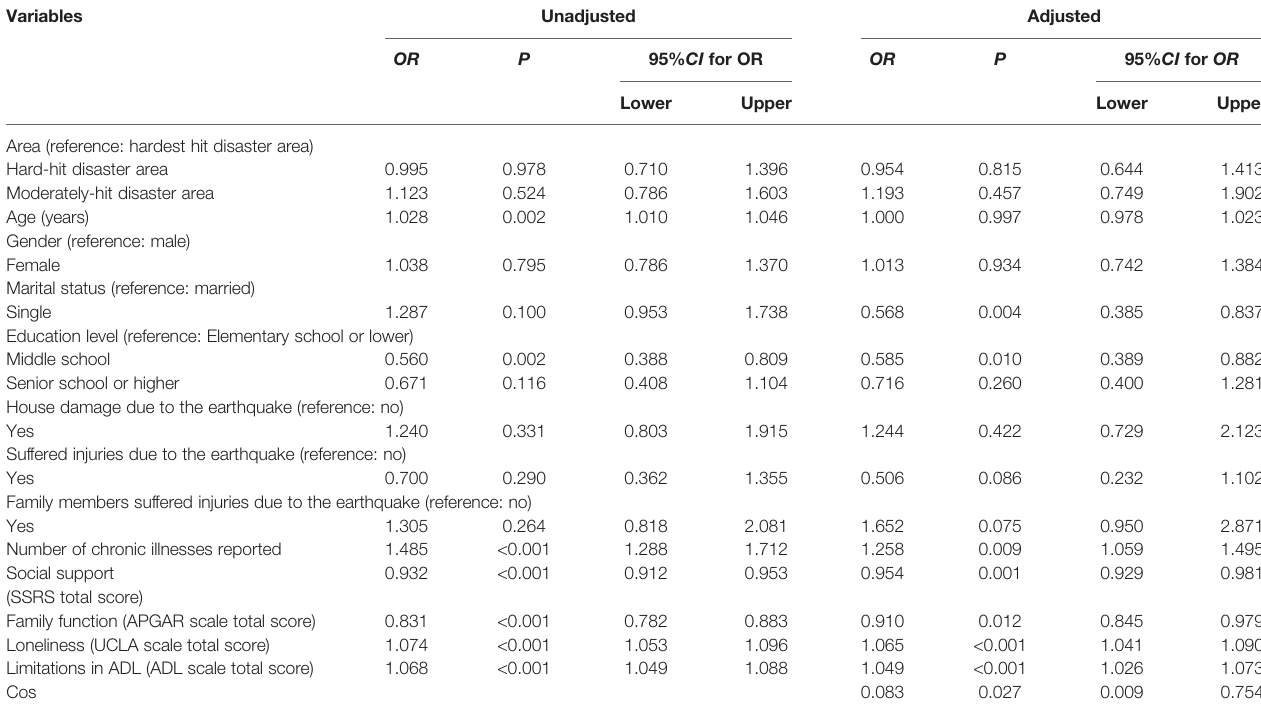
TABLE 4 | Univariate (unadjusted) and multivariate (adjusted) analyses of the prevalence (cutoff score of 8) of depression by potential risk factors (n = 962). Variables Unadjusted Adjusted OR P 95% CI for OR OR P 95% CI for OR Lower Upper Lower Upper